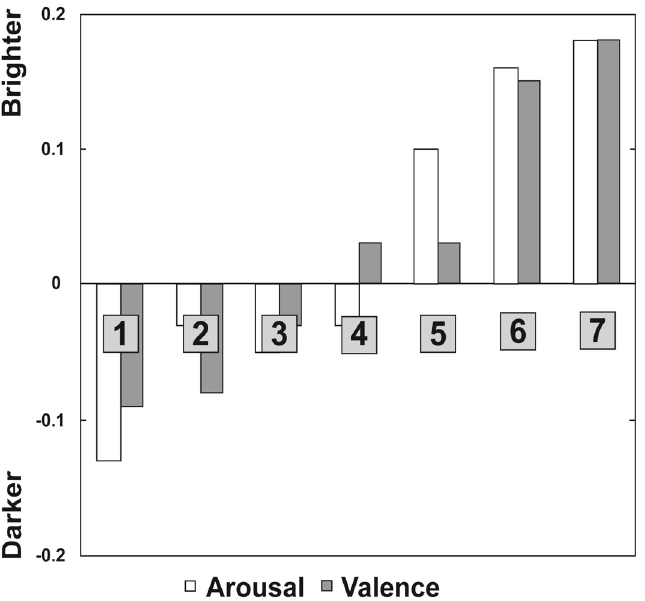
Fig 2. Brightness judgment bias of Experiment 1. Average brightness judgment bias separately for every level on the 7-point Likert scales of Valence and Arousal.